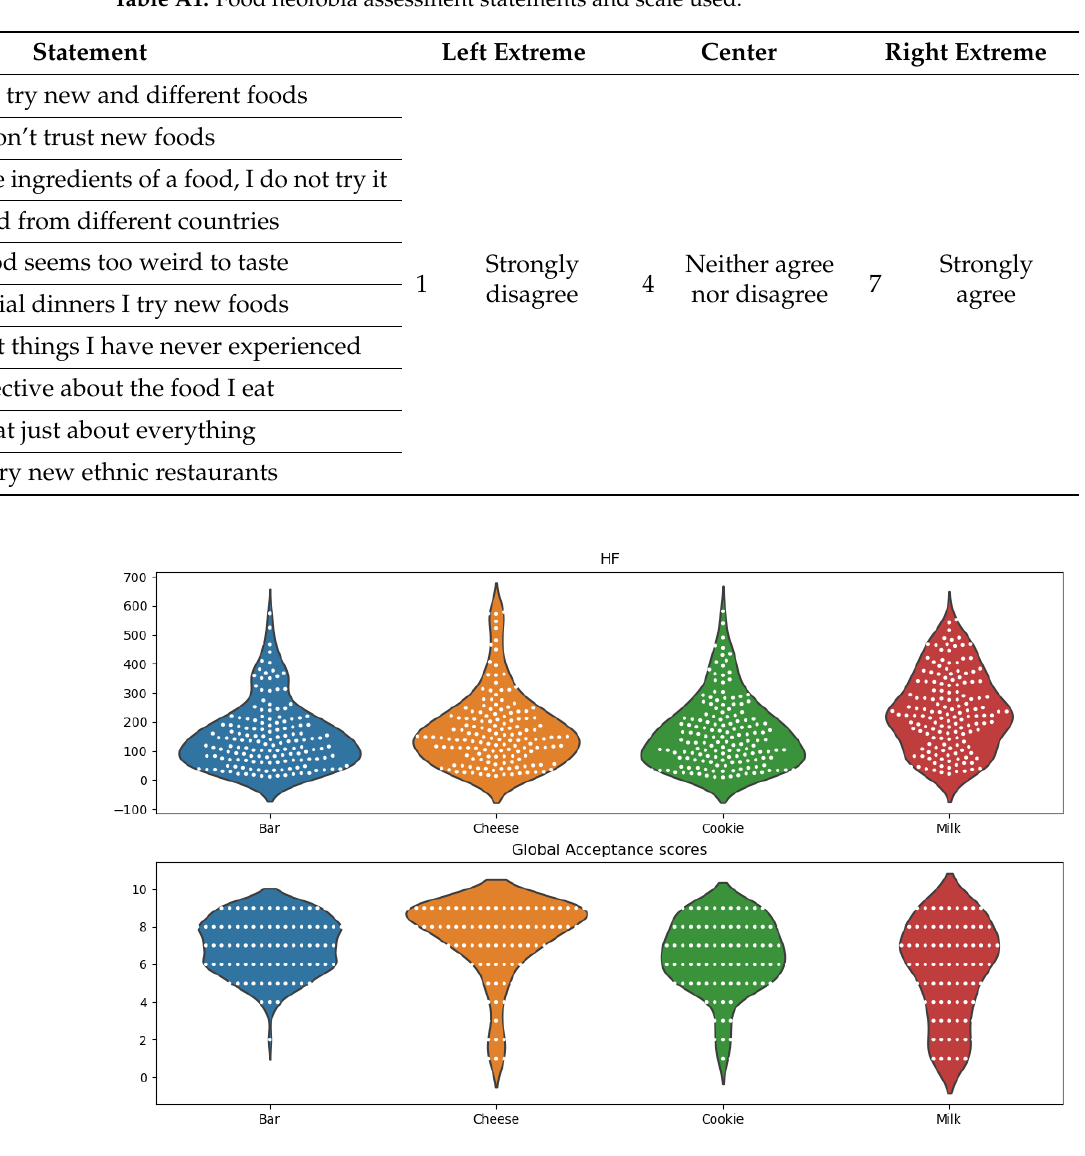
Figure A3. Distribution of the HRV HF feature values and global acceptance score for each product across 156 experiments (experiments with outlier values of HF were removed). On top : Distribution of HF values obtained in the first 2.5 min of contact with each product. Bottom : Distribution of the classifications obtained in the global acceptance